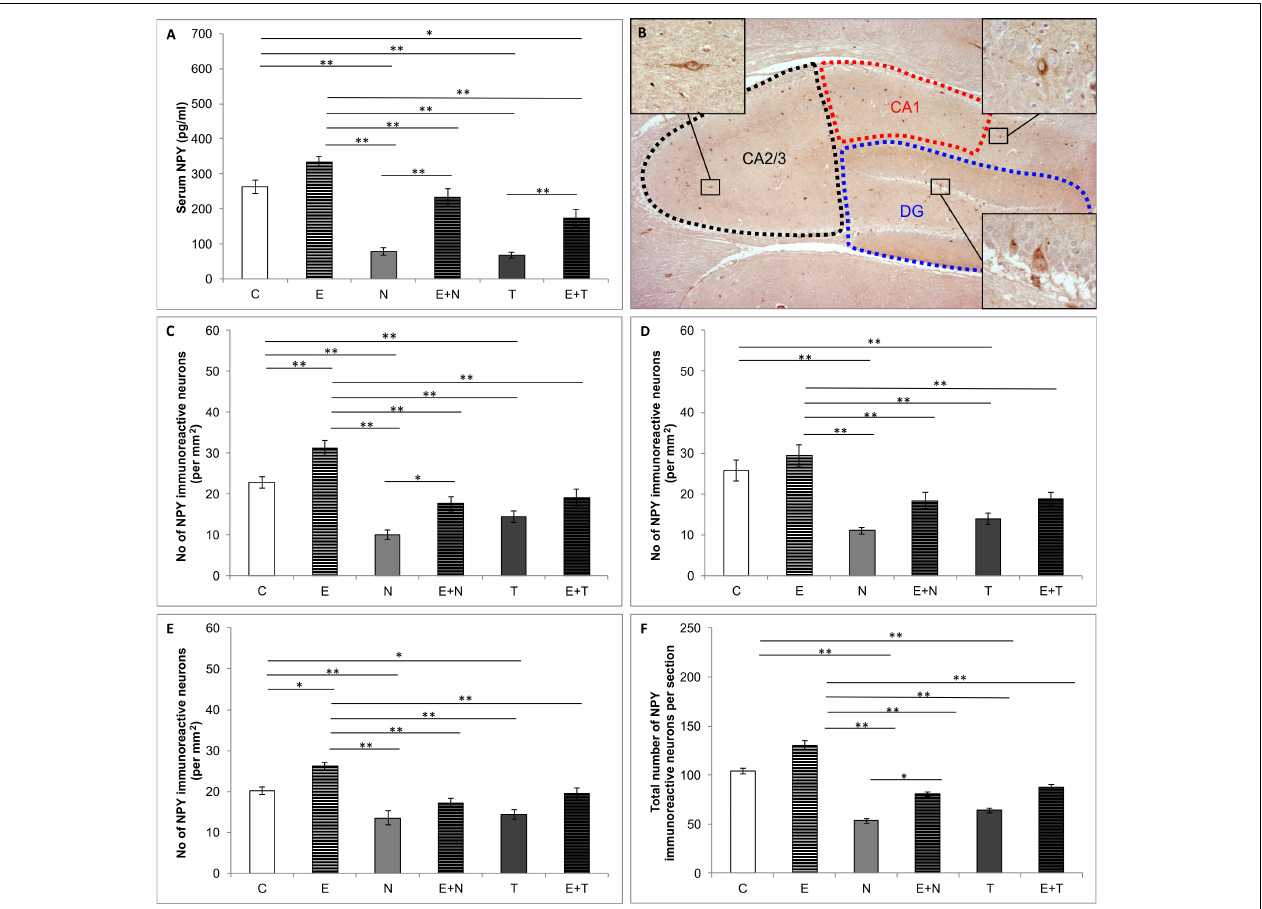
FIGURE 3 | Quantification of NPY content. (A) Serum NPY levels; (B) Distribution of immunoreactive NPY neurons in hippocampus; (C–F) The number of NPY immunoreactive neurons in CA1 (C) , CA2/3 (D) , DG (E) and total hippocampal section (F) ; (C, control group; E, exercise group; N, nandrolone-decanoate group; E+N, exercise plus nandrolone-decanoate group; T, testosterone-enanthate group; E+T, exercise plus testosterone-enanthate group). Bars represent means ± SEM, ∗ denotes a significant difference p ≤ 0.025, ∗∗ denotes a significant difference p ≤